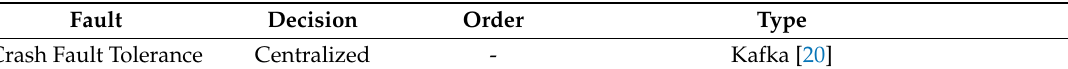
Table 7. Comprehensive categorization of consensus algorithms based on taxonomic